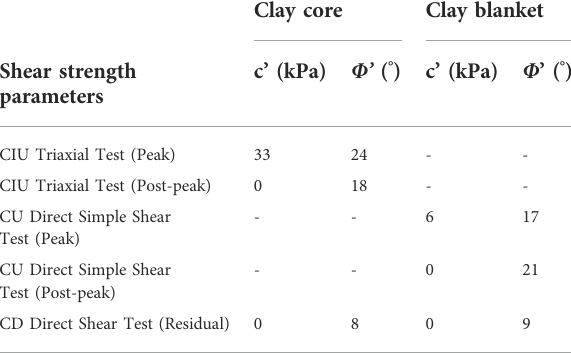
TABLE 3 Effective shear strength parameters. Clay core Clay blanket